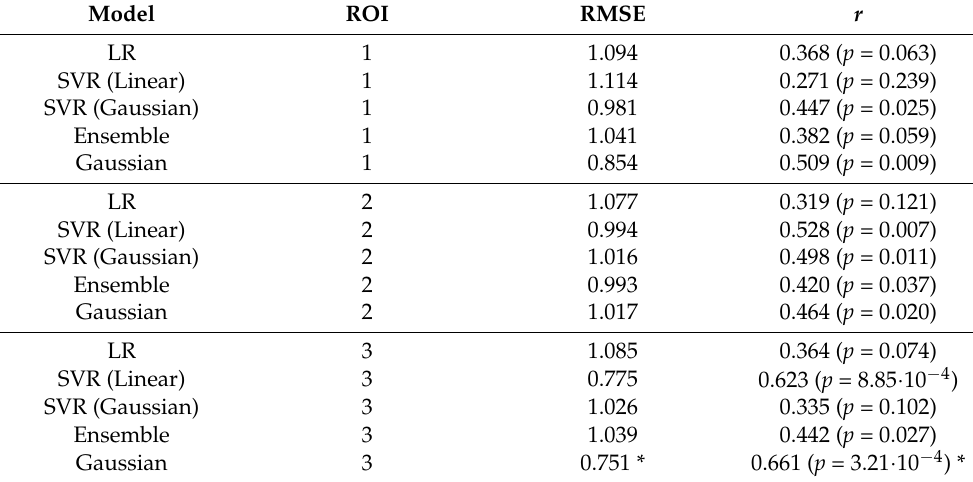
Table 3. The regression results obtained from the various ML approaches considered for estimating the MDF from thermal metrics. Notably, the model’s performance was expressed as the root mean square error (RMSE) calculated on the normalized (z-score) values and the correlation coefficient ( r ) between the gold standard (EMG-based MDF) and the predicted metric (IRI-based MDF). The best model is highlighted with an asterisk.